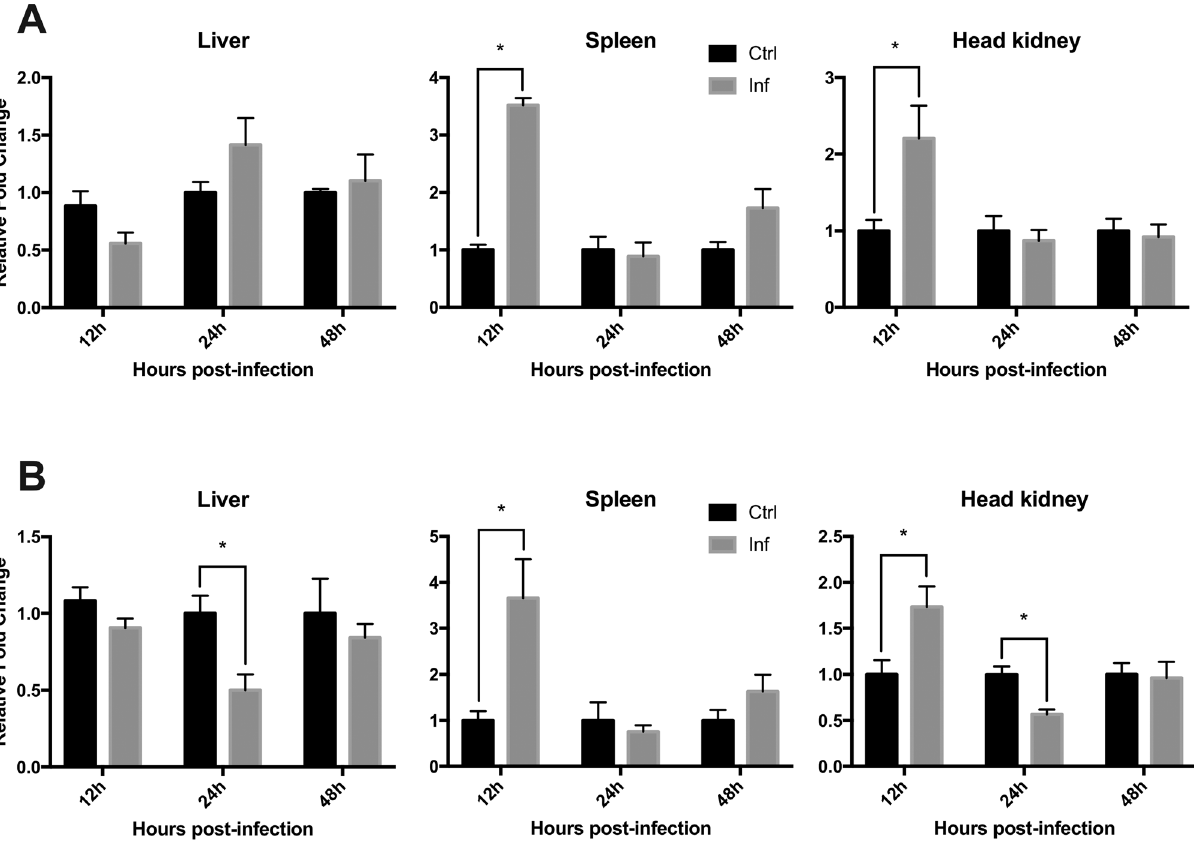
Figure 7 - Transcriptional expression levels of pmIL-1 (cid:2) (A) and pmIL-8 (B) in the liver, spleen and head kidney at 12, 24 and 48 h post-infection with A. dhakensis . Relative mRNA expression is expressed as fold change to the control samples at the same time point and was calculated using (cid:2) -actin as en- dogenousreference.Dataarepresentedasmean (cid:8) SEM(n=5).Asterisksindicatesignificantdifferencesbetweencontrol(Ctrl)andinfected(Inf)groups in Student’s t -test ( p (cid:7)